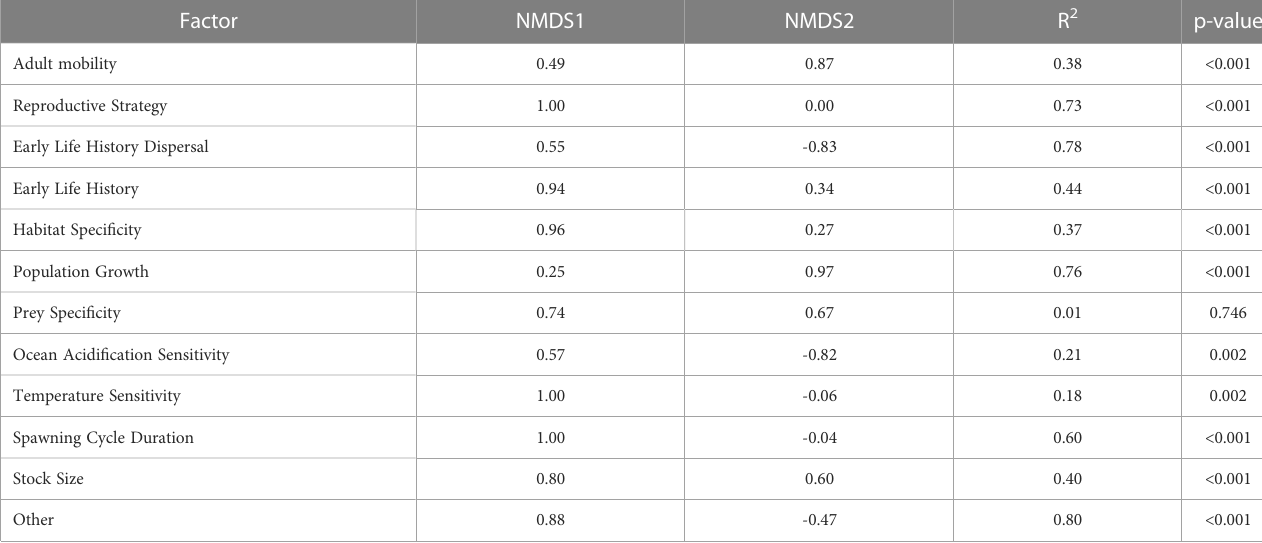
TABLE 6 Results from linear models relating the NMDS axes scores to each of the biological sensitivity factors.